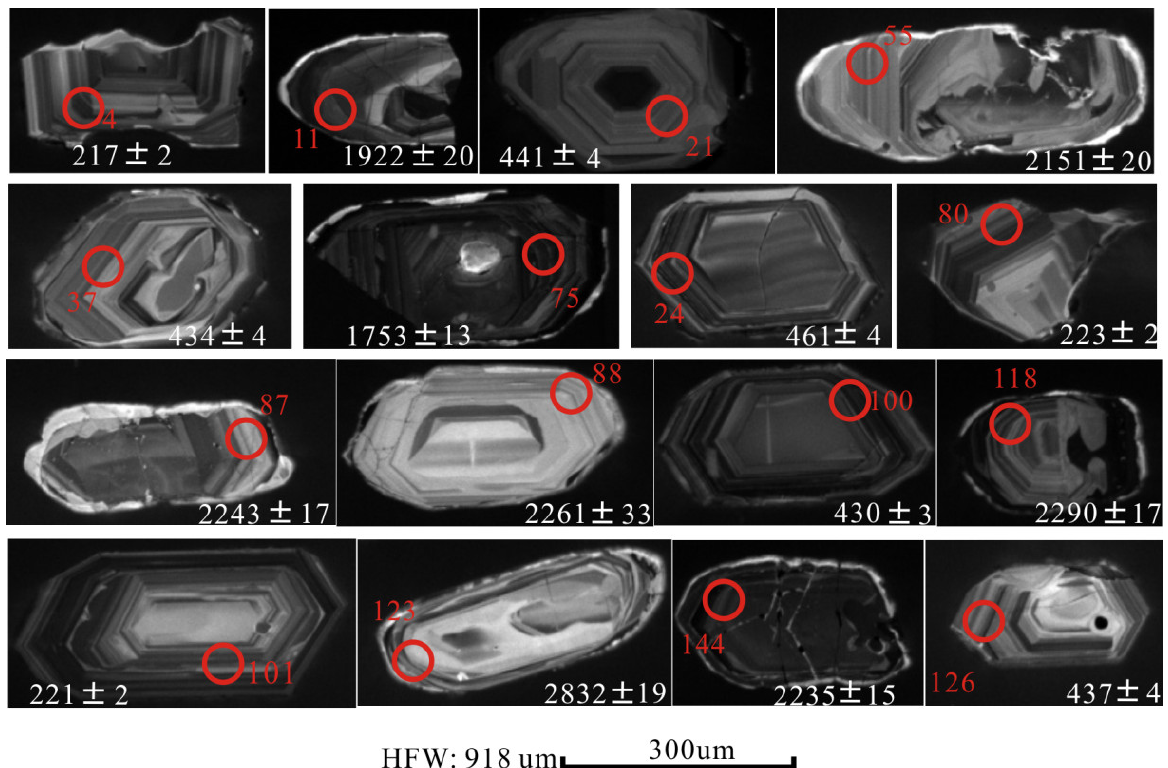
Figure 4. CL images and age value (Ma) of representative detrital zircons from the lower member of the Zhiluo Formation. The red circles on the images represent the analyzed spots, the red numbers show the serial number of the zircon, and the white numbers show the age in millions of years.